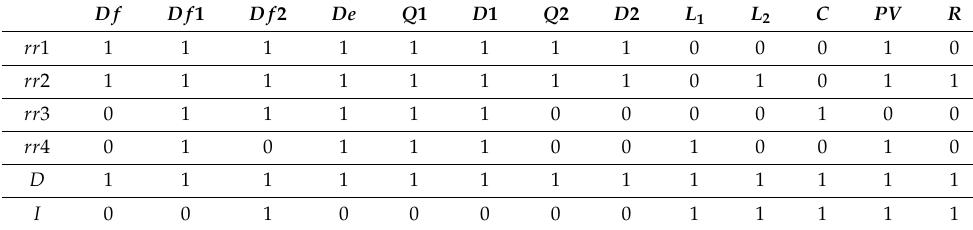
Table 2. Table of fault signatures of the power supply